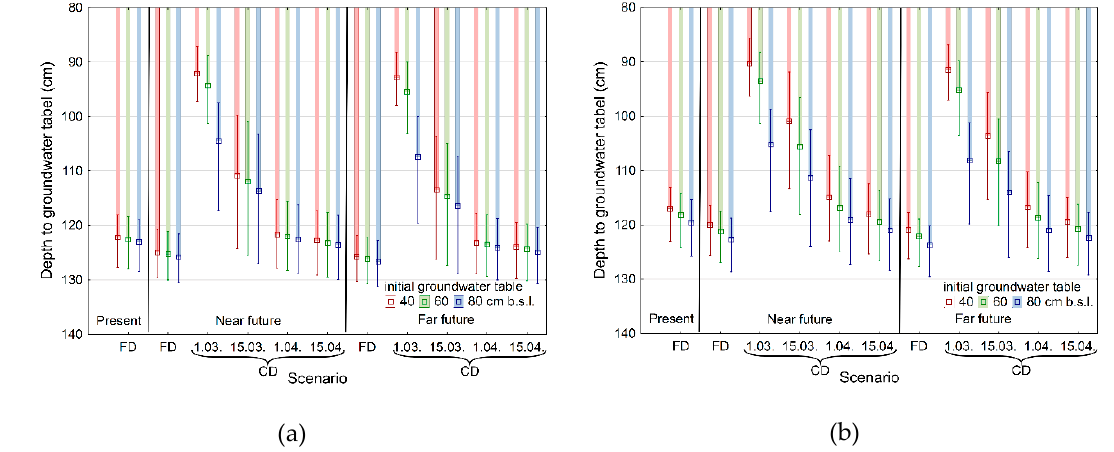
Figure 5. Depth to groundwater table in conventional network (FD-free drainage) and for the various CD scenarios of the 7 m ( a ) and 14 m ( b ) drainage network spacing in the near and far future, compared to the results of the conventional network at present. Bar charts with error bars show the average values, as well as the minimum and maximum values for the years 2014, 2017, and 2018.